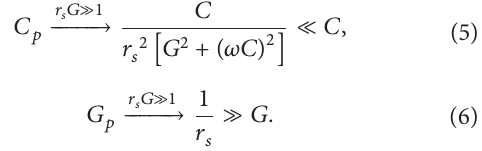
Figure 9: Parallel equivalent circuits modified for the interface trap capacitance 𝐶